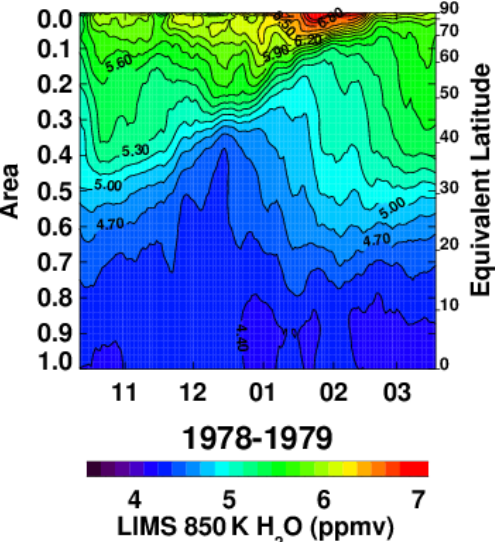
Figure 18. The same as Fig. 17 but for V6 H 2 O at 850K; contour interval is